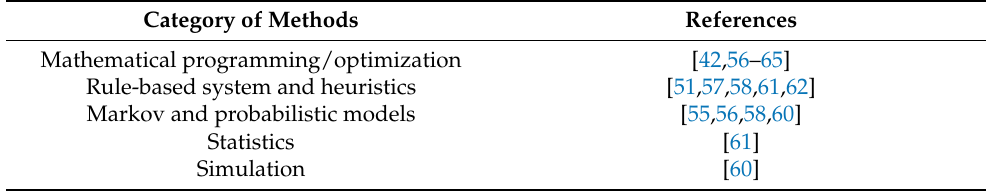
Table 9. Methods for multi-state and multi-component systems optimization.